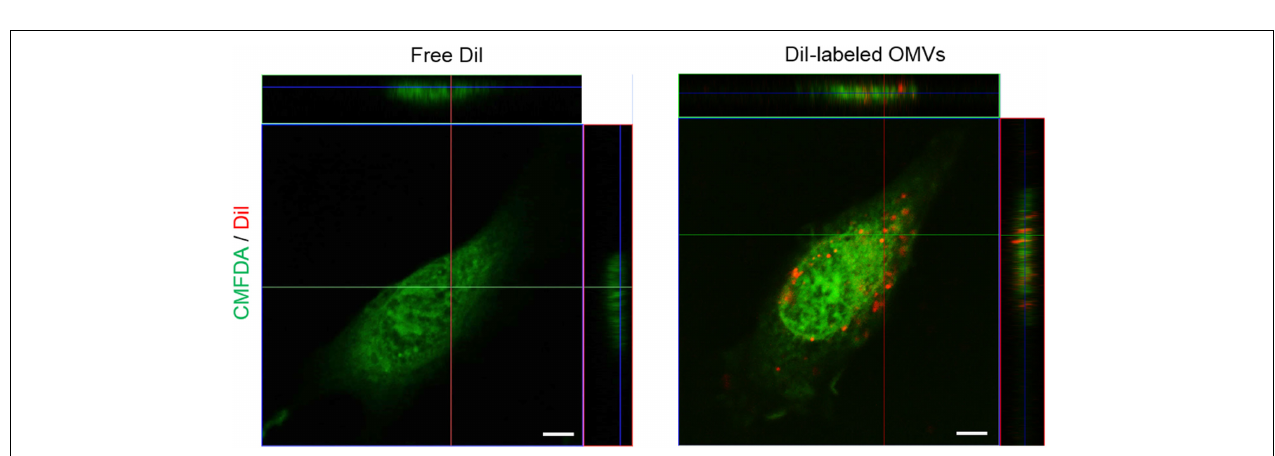
FIGURE 3 | Internalization of OMVs into endothelial cells. Uptake and internalization of free DiI control or DiI-labeled E. coli OMVs (red fluorescent signal) by HMEC-1 labeled with 5-chloromethylfluorescein (CMFDA, green fluorescent signal) was examined using a confocal microscopy. Representative three-dimensional fluorescence images are shown here. Scale bars = 5 µ m. Note that free DiI control or DiI-labeled E. coli OMVs were prepared by a size-exclusion spun column to remove residual DiI: free DiI control itself does not contain any fluorescent signal. Low magnificent two-dimensional fluorescence images and high magnificent two-dimensional fluorescence images with representative three-dimensional fluorescence images are shown in Supplementary Figure 3 .